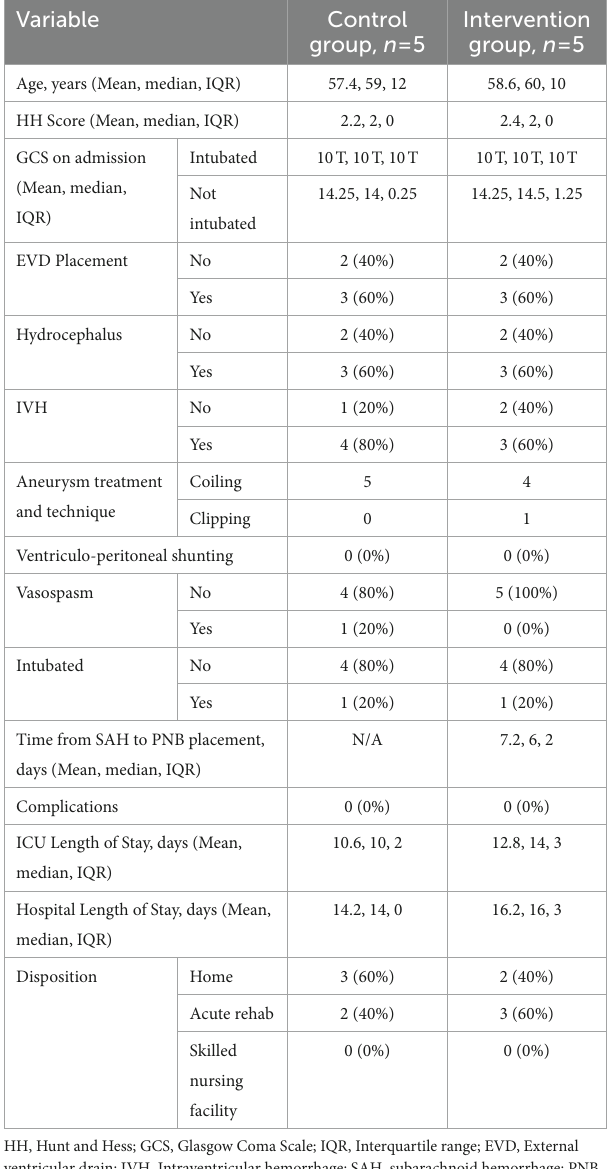
TABLE 1 Demographic variables in control and intervention